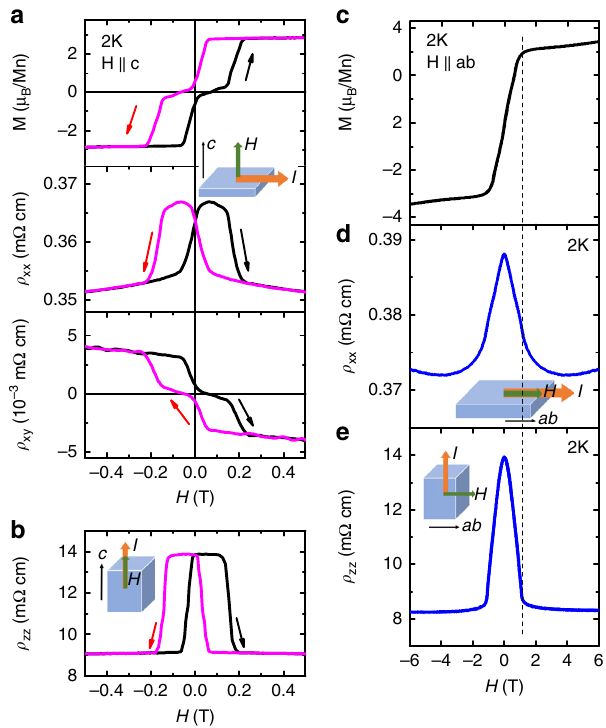
Fig. 2 Magnetotransport of bulk AFM MnBi 4 Te 7 . a The fi eld dependent magnetization M , transverse magnetoresistivity of ρ xx , and Hall resistivity ρ I || ab and H || c . b The longitudinal magnetoresistivity of ρ xy at 2 K with at 2 K with I || H || c . c The fi eld dependent magnetization M with H || ab at 2 K. d The longitudinal magnetoresistivity of ρ xx , at 2 K with I || H || ab . e The transverse magnetoresistivity of ρ zz , at 2 K with I || c and H || ab .